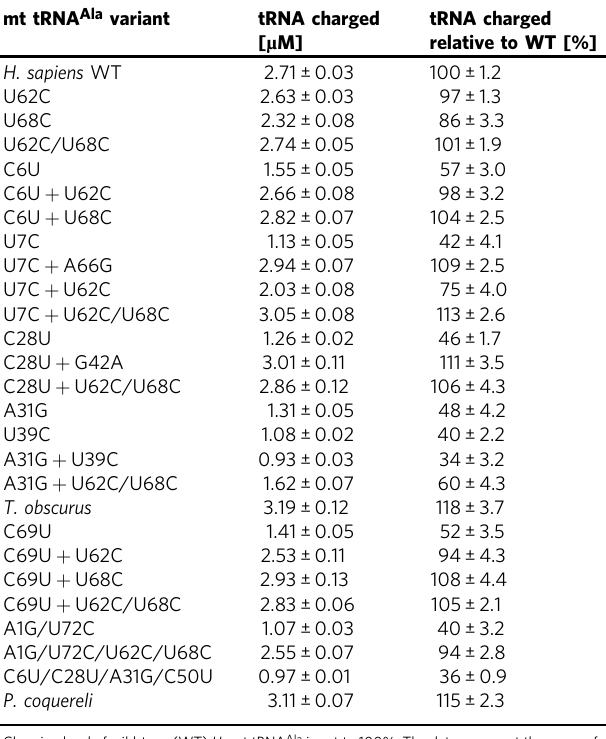
Table 2 Charging levels of mt tRNA Ala constructs (related to Fig.